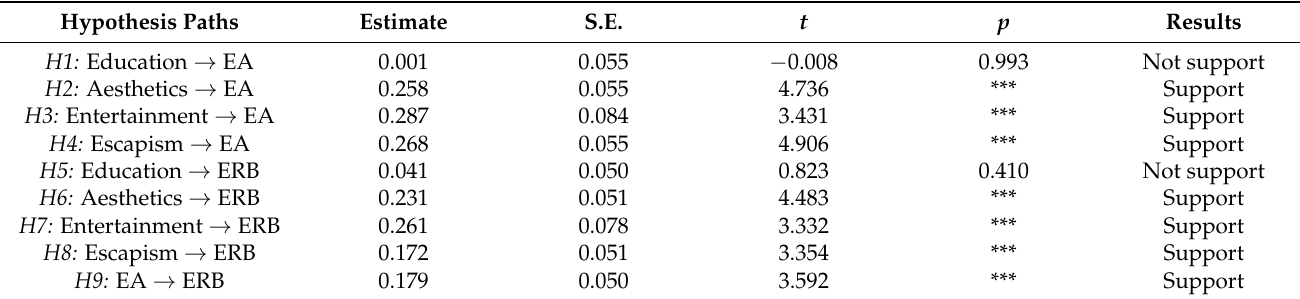
Table 4. Hypothesis testing